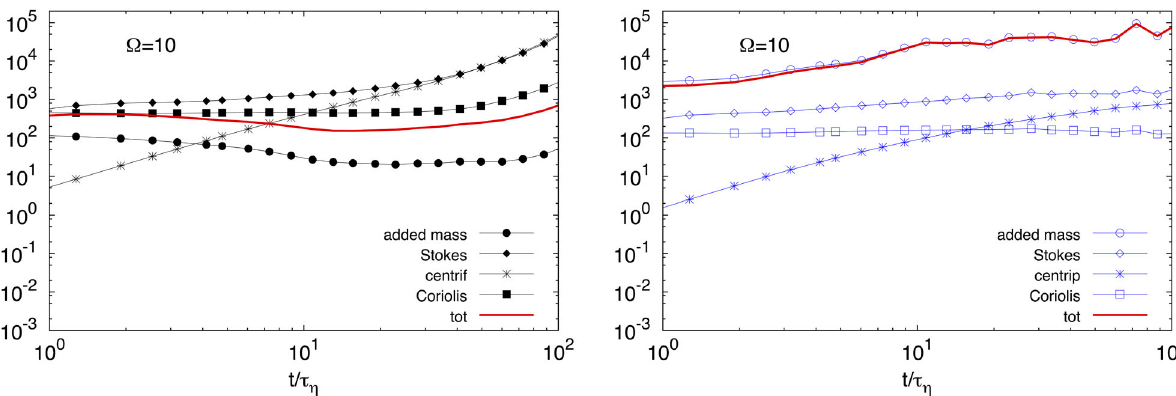
FIG. 8. Log-log plot of the time evolution of the contribution of the different forces to the rms particle acceleration, at resolution N ¼ 2048 and for high rotation (low Rossby number). Left: Inertial heavy particles, with β ¼ 0 . 4 and St ¼ 0 . 7 (family H 2 in Table II). Right: Inertial light particles, with β ¼ 1 . 6 and St ¼ 0 . 7 (family L 8 in